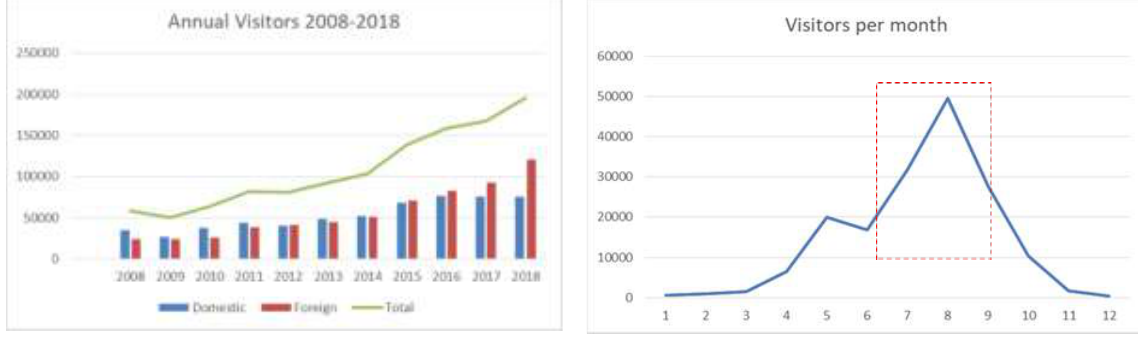
Figure 8: Growth in annual visitor numbers and peak months At current rates of growth, estimates suggest that by 2023 (Year 5) some 300,000 people will visit Butrint, the majority (at least 60%) being